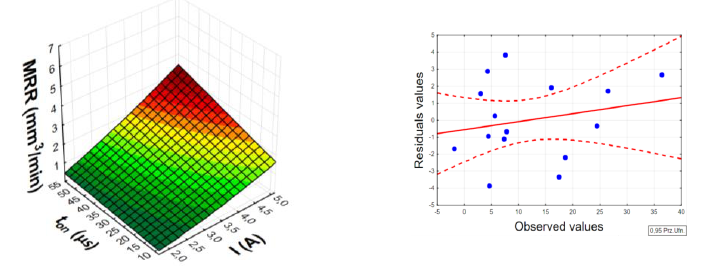
Figure 3. Schematic diagram of the experimental set-up.